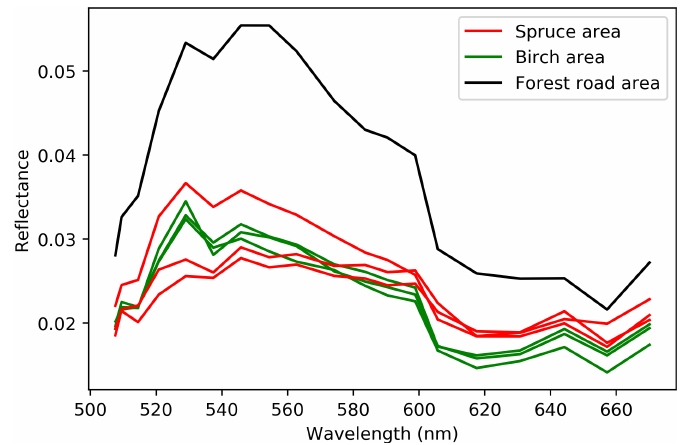
Figure 3. Median spectrum from each plot 1–7 described in Figure